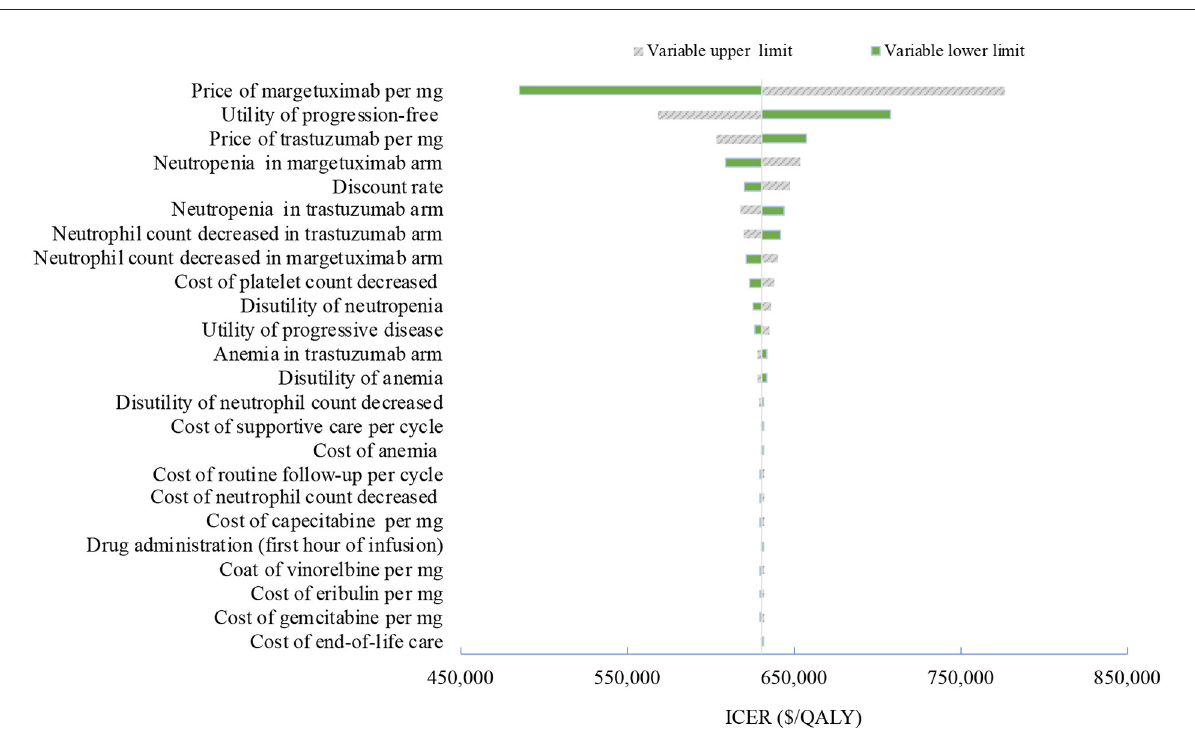
FIGURE2 Tornado diagram of one-way sensitivity analyses of margetuximab vs. trastuzumab in the treatment of pretreated ERBB2-positive advanced breast cancer from the Chinese perspective. QALYs, quality-adjusted